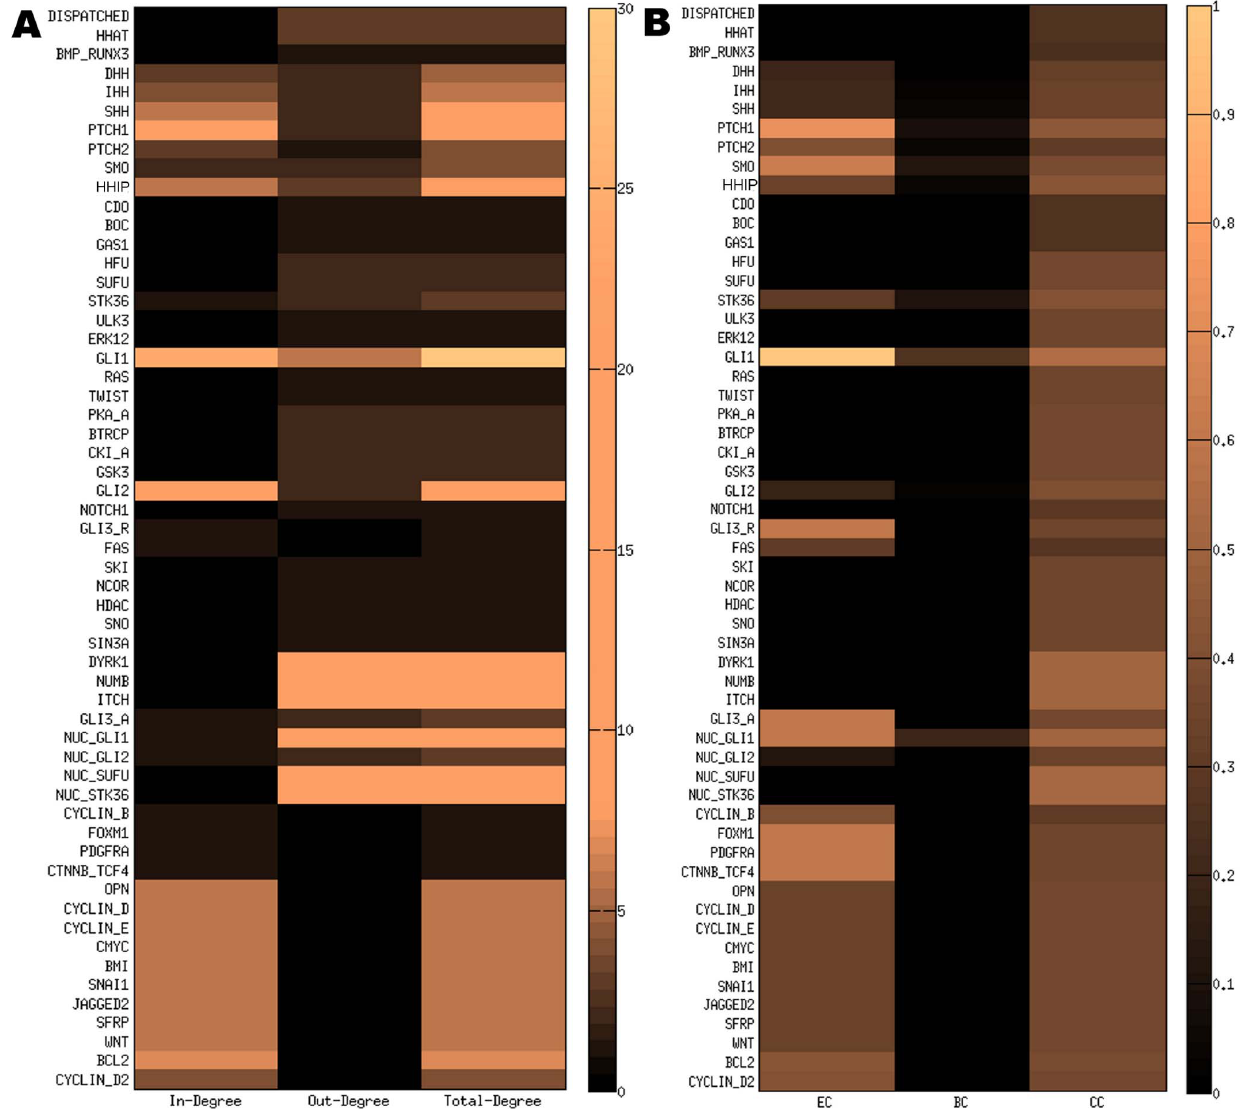
Figure 3. Parameter values from Connectivity and Centrality Analysis. Heat map of the values of the parameters used in Connectivity and Centrality analysis. The names of the proteins or nodes are arranged row wise (Y-axis) according to the position of their corresponding region (Figure 1). The parameter values are arranged column wise (X-axis) in the heat map. (A) Heat map of the values of the parameters values used in connectivity analysis: IN-DEGREE, OUT-DEGREE and TOTAL DEGREE of each protein. High IN-DEGREE value of GLI1, PTCH1, HHIP and SHH indicates their higher number of up-regulation by the other proteins in the network. High OUT-DEGREE value of several nuclear proteins (e.g. DYRK1, NUMB, NUC_GLI1, NUC_SUFU, NUC_STK36 etc.) refers their ability to regulate other proteins in HH network. In case of total degree, GLI1, GLI2 and NUC_GLI1 have significant highest value. It refers that these two proteins are mostly connected to the other proteins in the network. (B) Heat map of the individual centrality score of each protein of Hedgehog map. The Centrality measurement parameters used in this analysis were Eigenvector (EC), Betweenness (BC) and Closeness (CC) centrality. It is observed that GLI1 has the highest value for each parameter score. Subsequently, PTCH1, PTCH2, HHIP, STK36, NUC_GLI1, NUC_GLI2 etc. are also showing significant value for each individual centrality